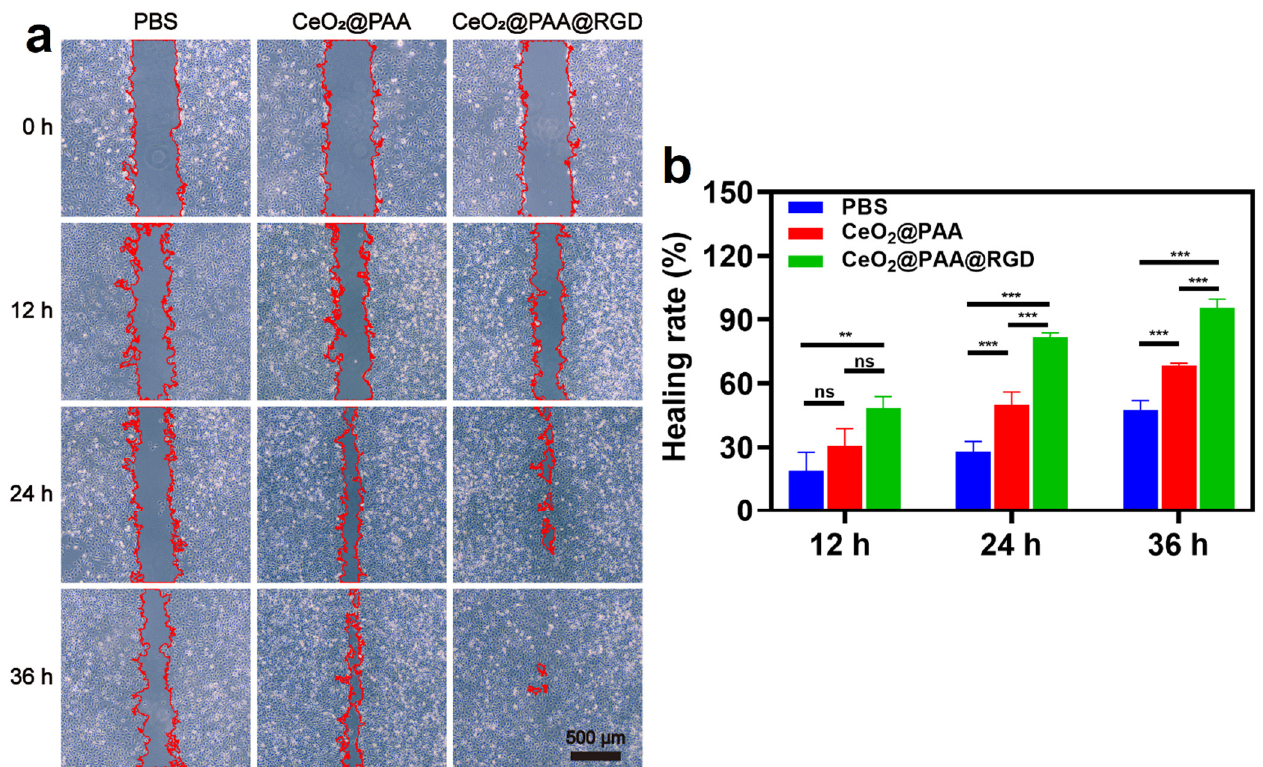
Figure 6. The migration of HUVEC was observed by microscopy in vitro. ( a ) The representative pictures of cell migration after treatment with PBS, CeO 2 @PAA, and CeO 2 @PAA@RGD nanoparticles for 0 h, 12 h, 24 h, and 36 h (red areas indicate scratch areas; scale bar = 500 µm); ( b ) quantification of scratch healing rate of HUVEC cells treated with PBS, CeO 2 @PAA, and CeO 2 @PAA@RGD nanoparticles. Error bars = mean ± standard deviation (SD) ( n = 3); ns > 0.05, ** p < 0.01, *** p < 0.001, using a one-way ANOVA (and nonparametric or mixed).